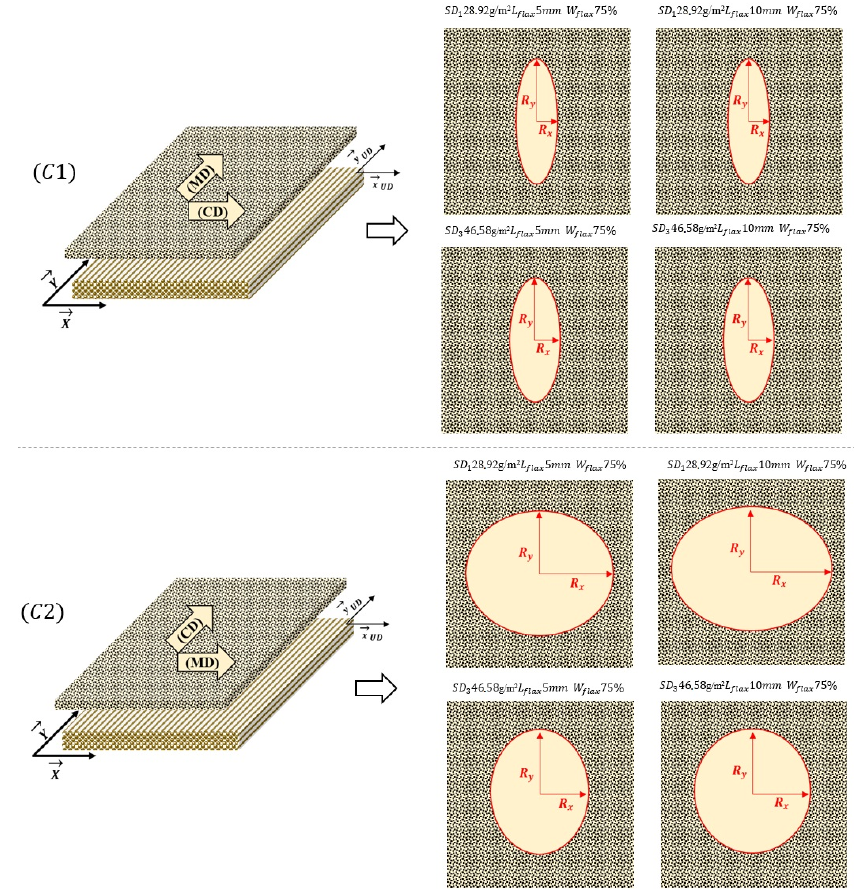
Figure 11. Comparison of predicted reinforcement flow front shapes for two different paper layer orientations.